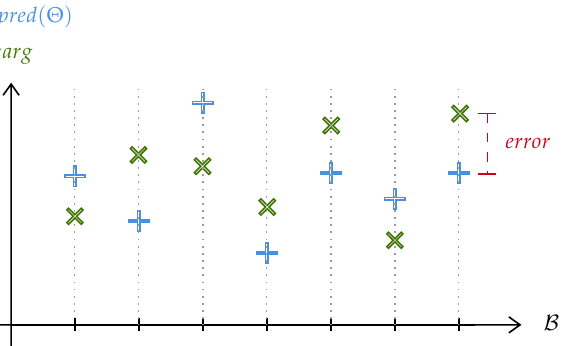
Figure 6. Representation of predicted and targeted values and the corresponding error for items of a